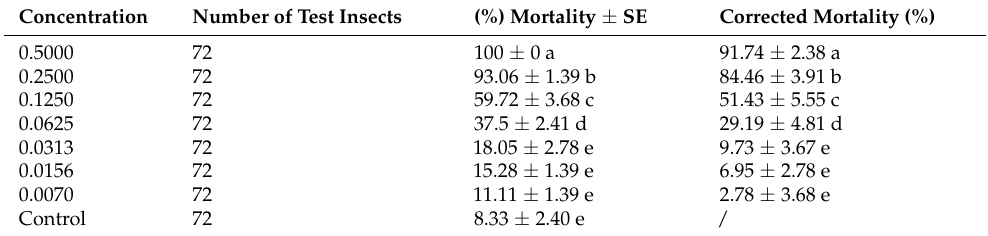
Table 1. Lethal effects of different concentrations of EMB on FAW third instar larvae 24 h post-treatment. Concentration